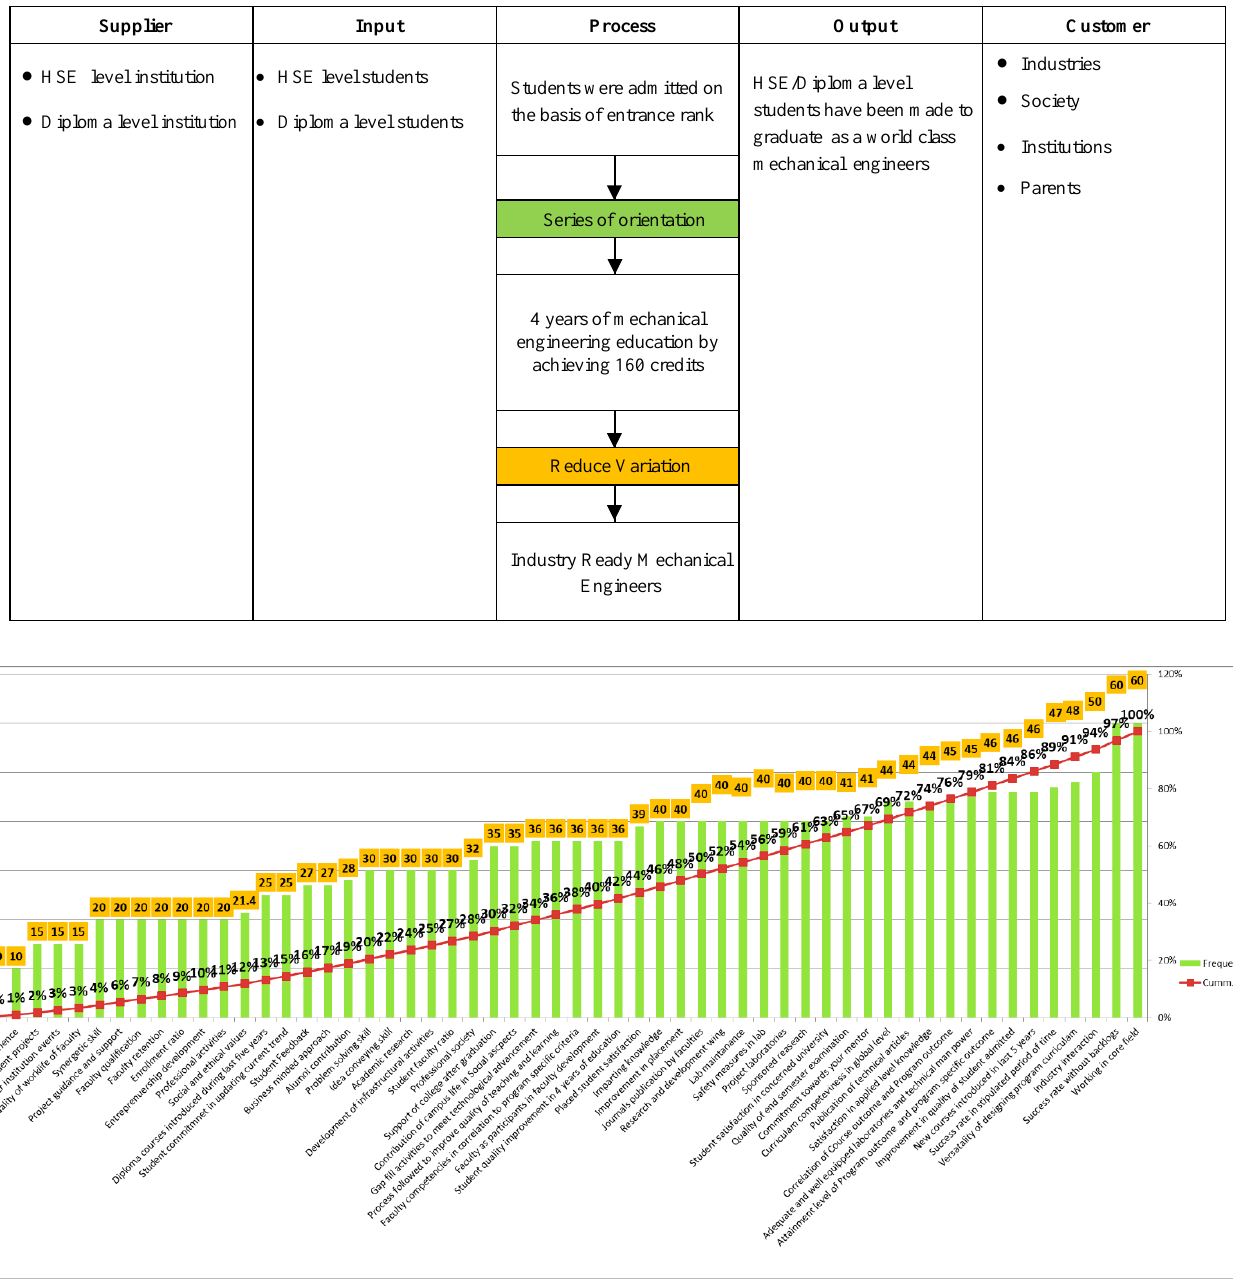
Figure 2. Pareto